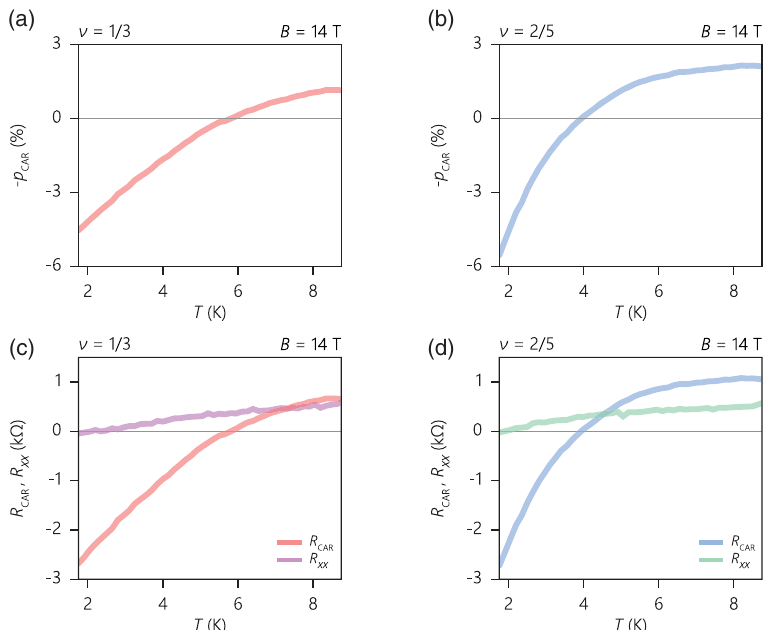
FIG. 16. Temperature dependence of crossed Andreev reflection at ν ¼ 1 = 3 and 2 = 5 in device 1. (a) shows the CAR probability at ν ¼ 1 = 3 , (b) shows that at ν ¼ 2 = 5 . (c) and (d) respectively show R Probability of crossed Andreev reflection in fillings ν ¼ 1 = 3 and 2 = 5 is rapidly increasing with decreasing T down to the lowest temperature, at which bulk conductance vanishes ( R